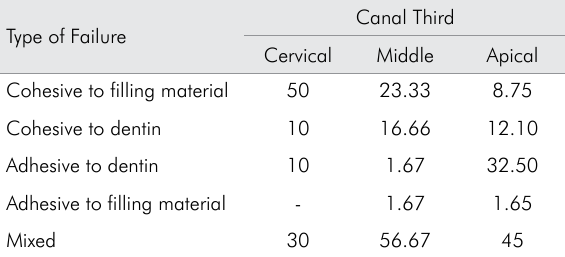
Table 4. Frequency of failure types (%) by root